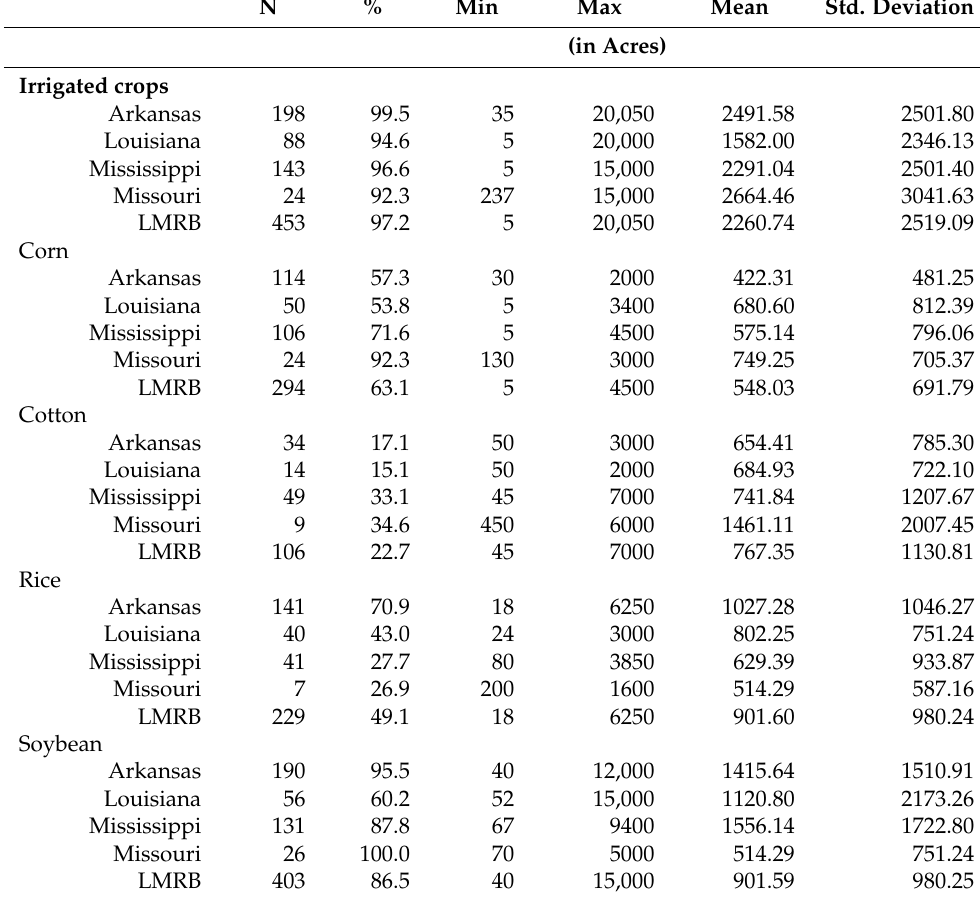
Table 3. Summary statistics of irrigated crop choices and